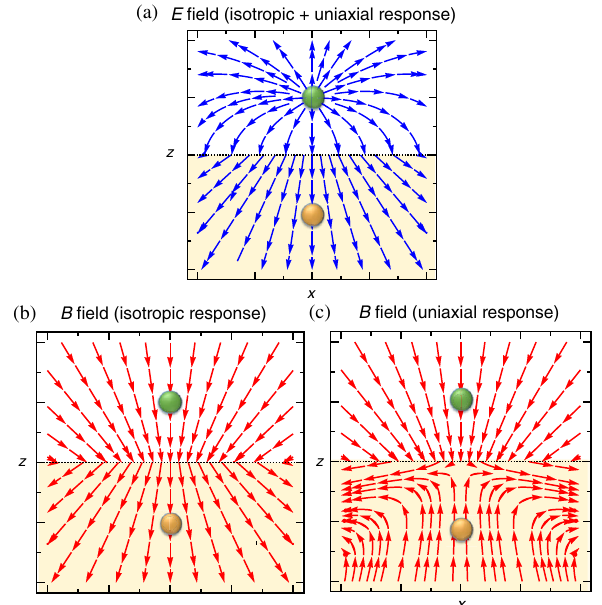
FIG. 2. Calculated E (a) and B (b),(c) fields induced by a positive charge close to a magnetoelectric surface in Cr 2 O 3 . The green and orange circles mark the position of the charge and the image charges. The arrows indicate the orientation of the fields calculated using an averaged isotropic magnetoelectric response (b) and using the full anisotropic responses (c) of Cr 2 O 3 . The electric field (a) is indistinguishable for the two cases due to the small anisotropy in the dielectric